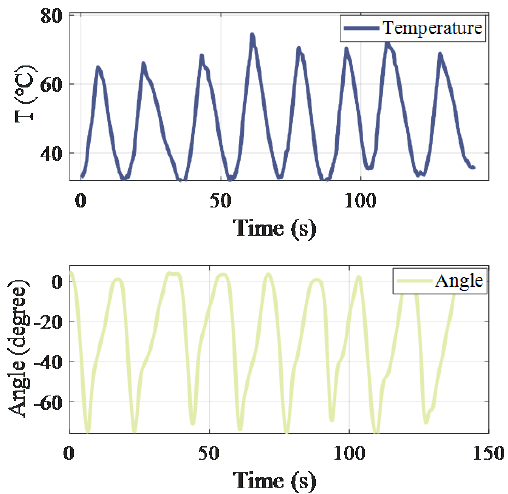
Figure 10. Experiment of elbow joint angle and SMA